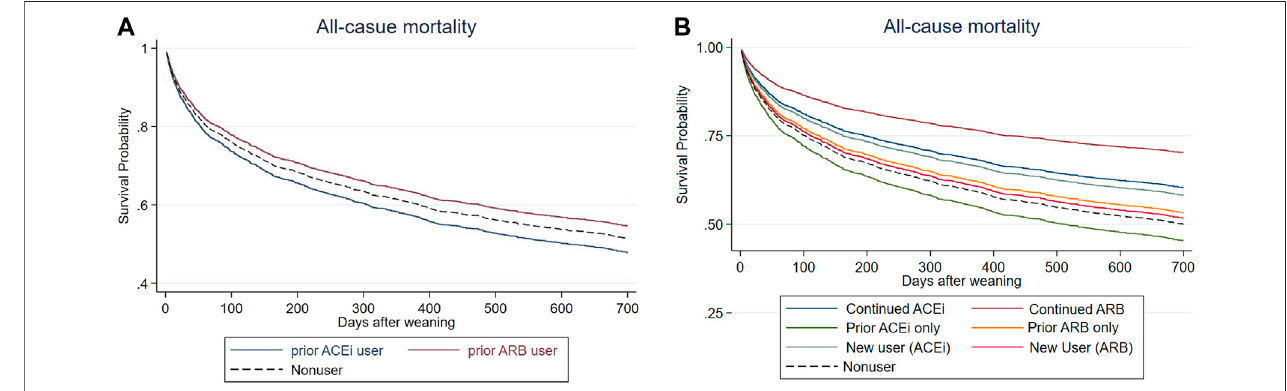
FIGURE 2 | Cox proportional plots depicting (A) survival probability levels of before-dialysis ARB and ACEi users, as well as nonusers, and (B) survival probability levels of prior ARB, prior ACEi, continuing ARB, continuing ACEi, and new users, as well as nonusers.